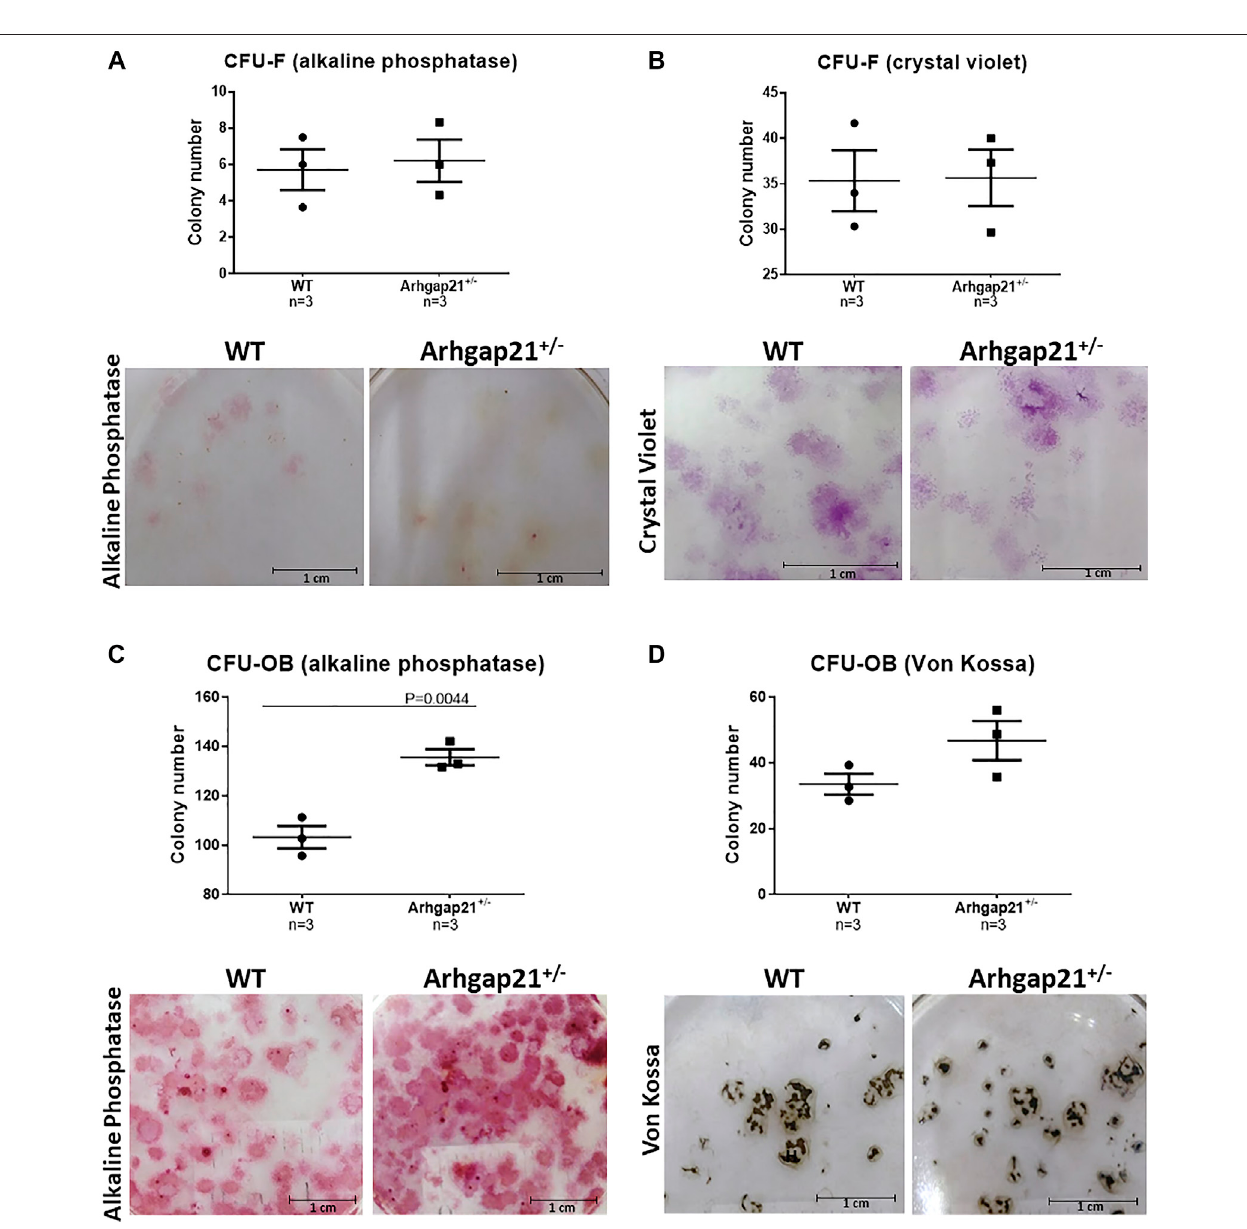
FIGURE 2 | Arhgap21 +/ − BM cells have a higher potential to form CFU-OB with activity for alkaline phosphatase. (A) Number of total CFU fi broblasts (CFU-F) positive stained for alkaline phosphatase or (B) crystal violet obtained from WT ( n (cid:2) 3) and Arhgap21 +/ − ( n (cid:2) 3) BM cells cultured for a period of 10 – 14 days. Representative photographs of the stained colonies are shown in the lower panels. (C) Number of alkaline phosphatase – positive CFU-OB and (D) Von Kossa – positive mineralized nodules formed from BM cells after 17 days of culture under osteoblast conditions. Representative photographs of the stained colonies are shown in the lower panels. We detected a signi fi cantly higher number of colonies with alkaline phosphatase activity formed from Arhgap21 +/ − BM cells compared with WT ( p (cid:2) 0.0044). Three independent biological experiments were performed in triplicate for each assay. (In all graphs, each dot represents an individual mouse; mean and standard error of the mean are shown; 2-way Student ’ s t